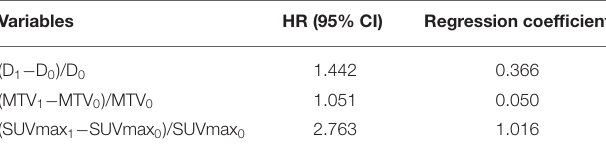
TABLE 2 | Separated estimated hazard ratio and Cox regression coefficients for overall survival for formulation of the new prognostic index (NPI). Variables